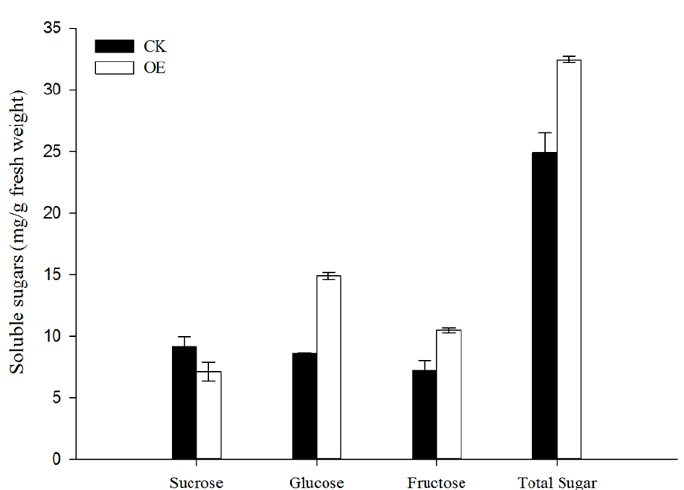
Figure 5. VvSWEET10 overexpression increases sugar accumulation in grapevine calli. The sugar contents of VvSWEET10 -overexpressed calli (OE) and the control (CK) were analyzed by HPLC. Results are shown as means ± SD (n = 2).